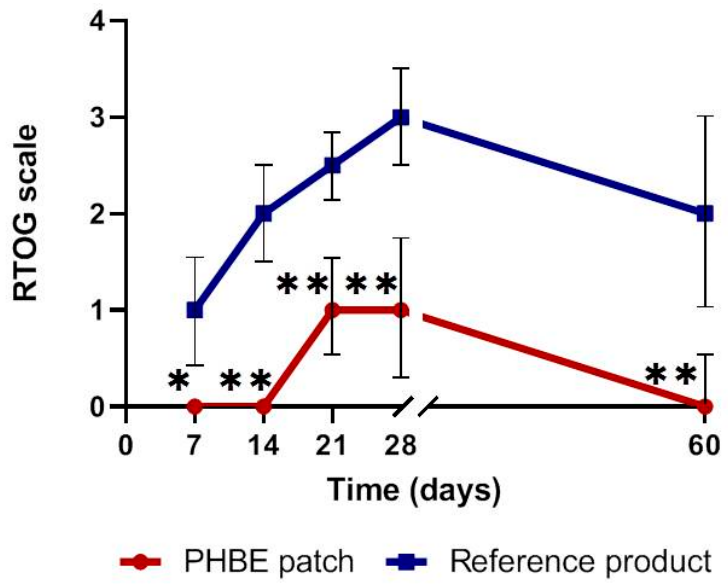
Figure 3. Clinical estimation of acute radiodermatitis based on RTOG criteria, before radiation therapy (RT) (Day 0); during Days 7, 14, 21, and 28; and 1 month after RT (Day 60). Significant differences were observed between the two interventions throughout the treatment period (* p < 0.05, ** p < 0.01). Total skin recovery was observed in the PHBE patch patients 1 month after RT (Day